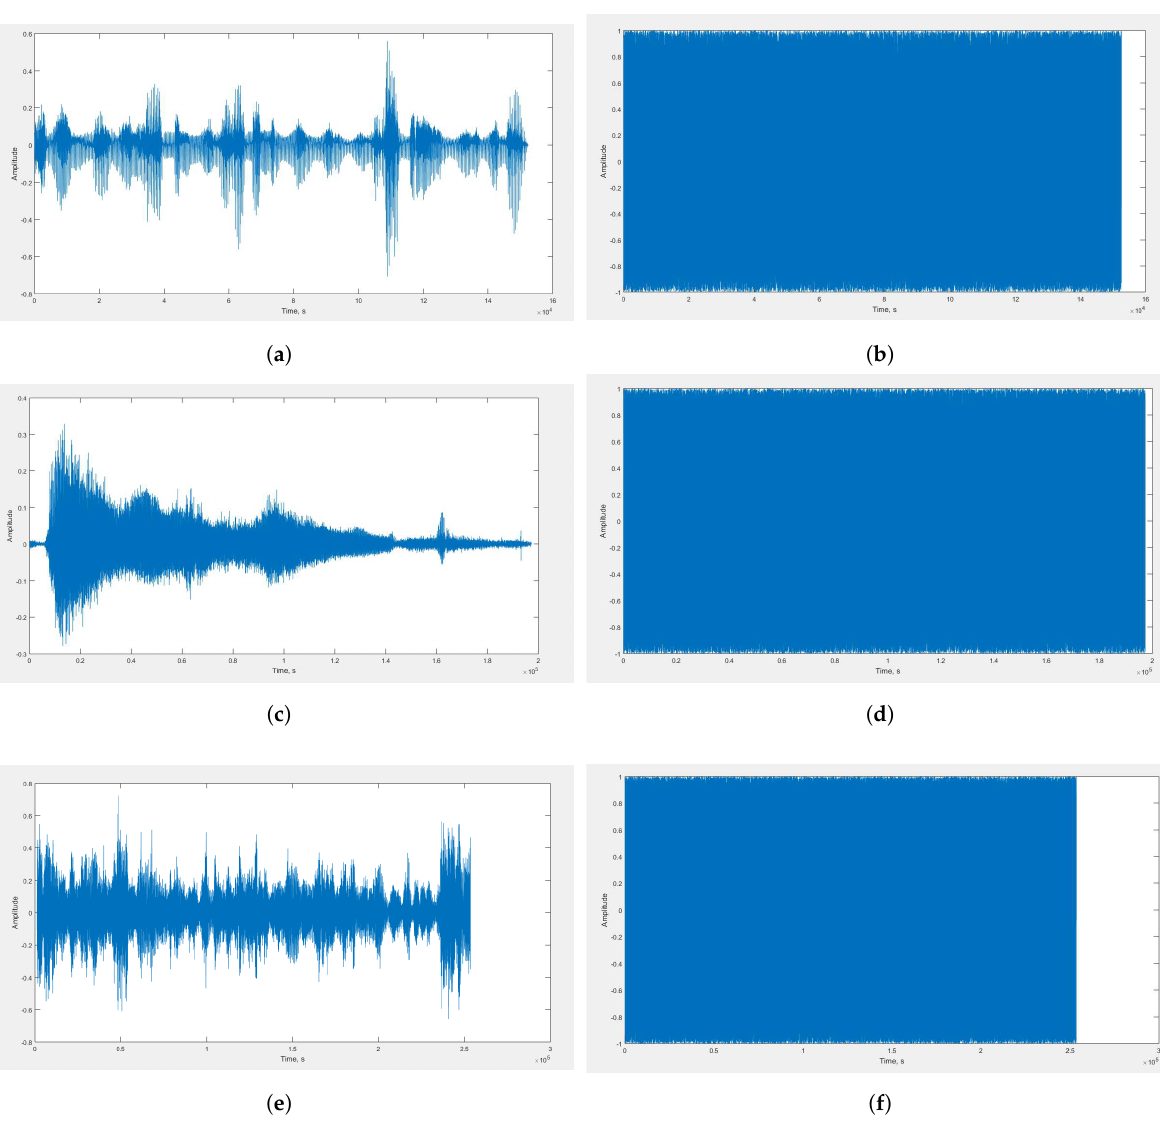
Figure 4. Waveform plotting of original and encrypted audio files: ( a ) cartoon-mumble-speak, ( c ) grito-wav and ( e ) a- strange-dream are the original input audio files; and ( b , d , f ) are the waveforms of the encrypted audio